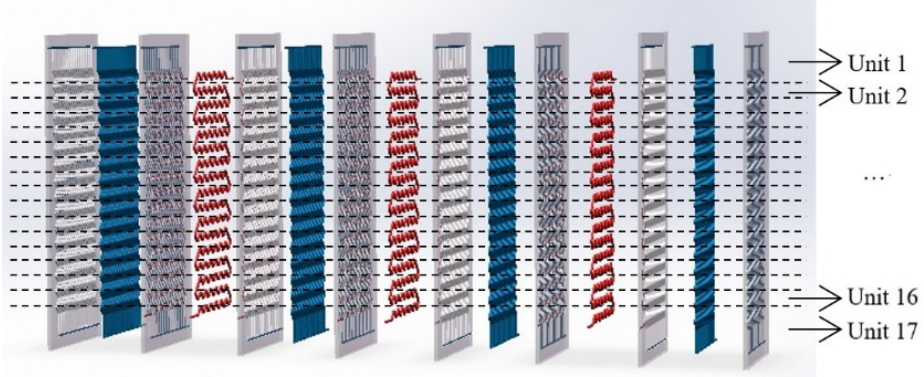
Figure 3. Description of units dividing.